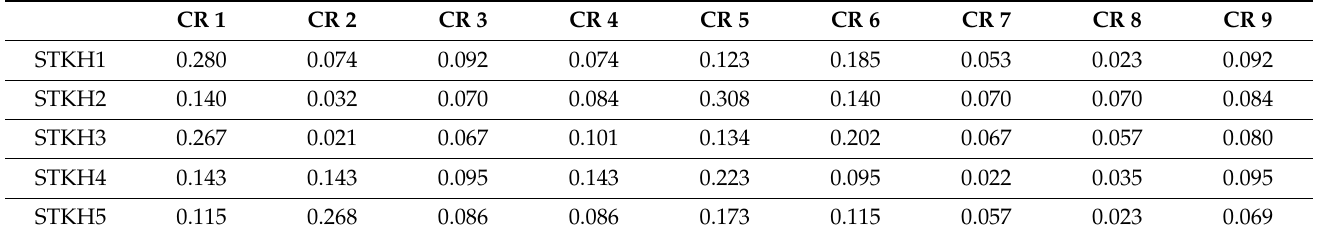
Table 4. Optimal weights of each criterion for each